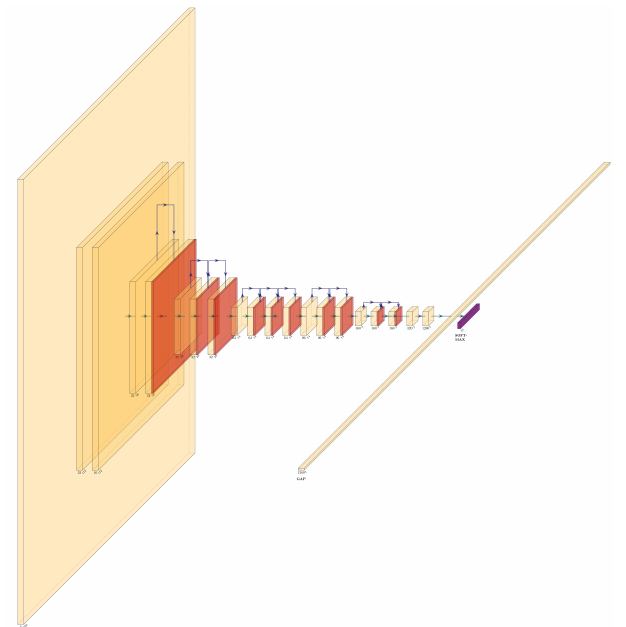
Figure 1. The network architecture of MobileNetV2, including the input layer, 19 bottleneck layers, the average pooling layer, and the prediction layer. A link on top of two adjacent blocks indicating the residual shotcut and the corresponding output block is colored differently using dark brown. Due to the size of the figure, the feature dimension is not